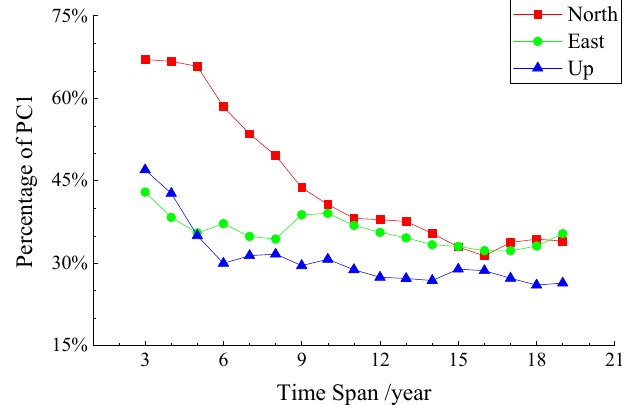
Figure 2. Percentages of the first-order principal component when extracting CMC of IGS stations in China with different time spans.